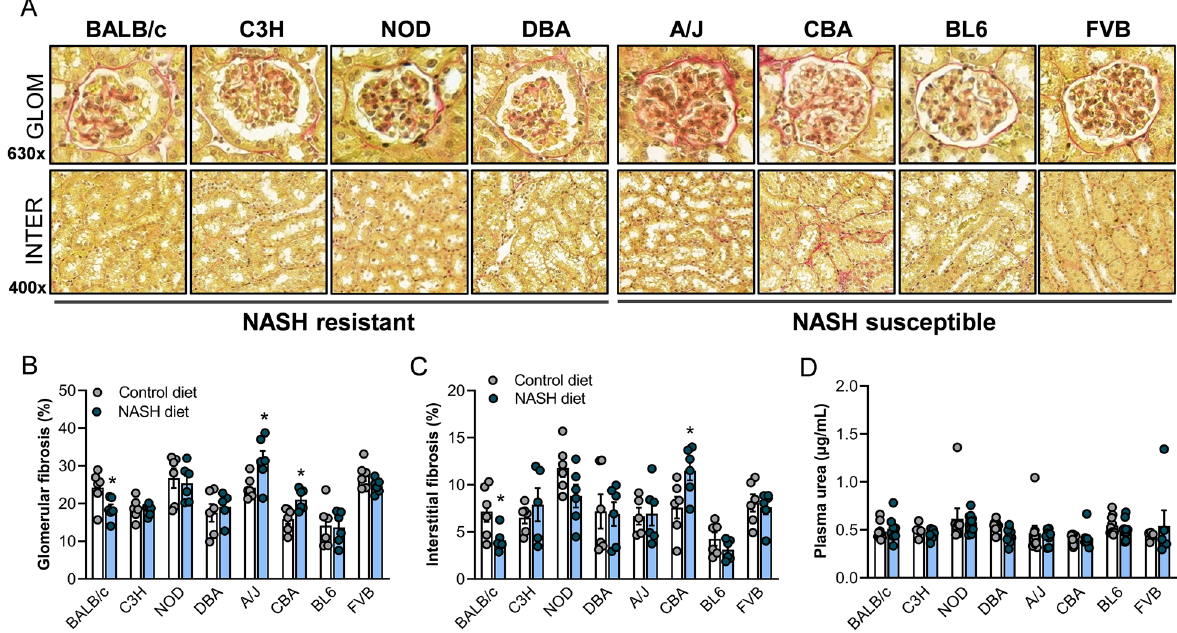
Figure 6. Assessment of renal fibrosis and plasma urea. ( A ) Representative renal glomerular and cortical interstitial histology (Picrosirius Red staining) in A/J, BALB/c, C3H/HeJ, C57BL/6J, CBA/CaH, DBA/2J, FVB/N and NOD/ShiLtJ mice fed a western-style diet, sorted by increasing prevalence of NASH and liver fibrosis. Percentage of glomerular ( B ) and interstitial ( C ) fibrosis (n = 5–6/group), and ( D ) plasma urea (n = 4–10/group) in all mouse strains. Data are means ± SEM, *p < 0.05 vs. respective controls, as assessed by two-way unpaired t-test.